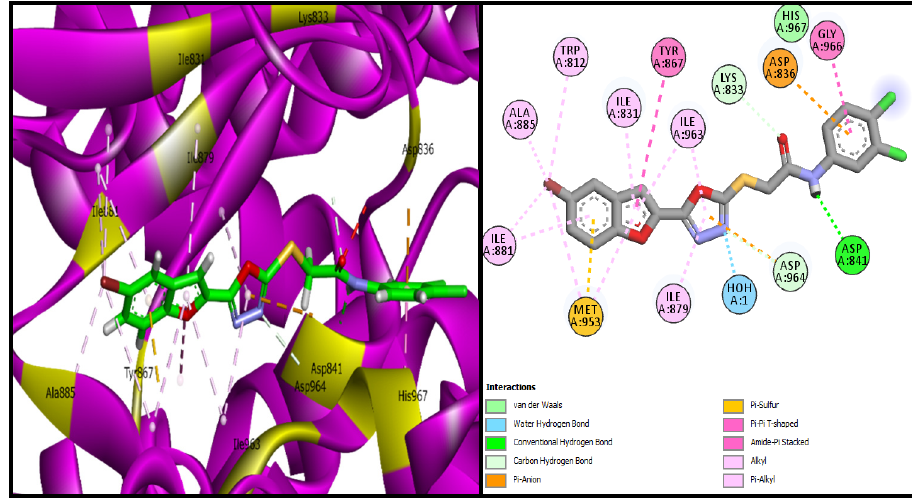
Figure 7. Three-dimensional and two-dimensional interaction images of the BF-2+PI3K protein complex.